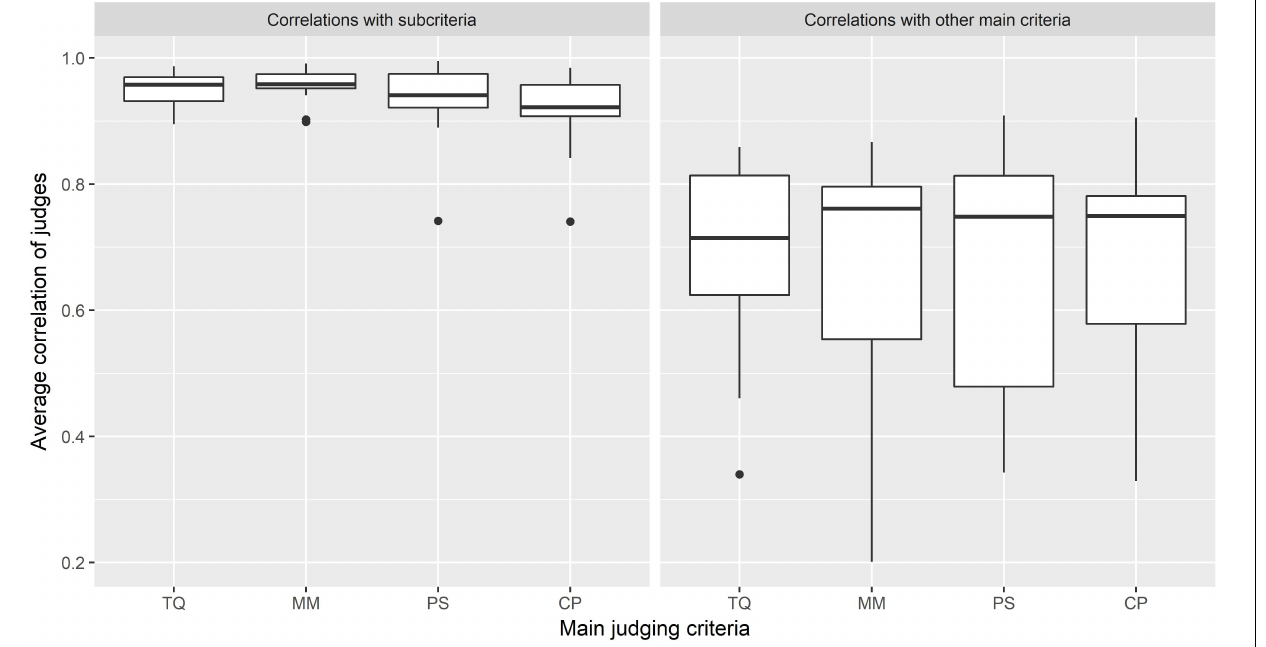
allowing them to ascribe value to a performance.